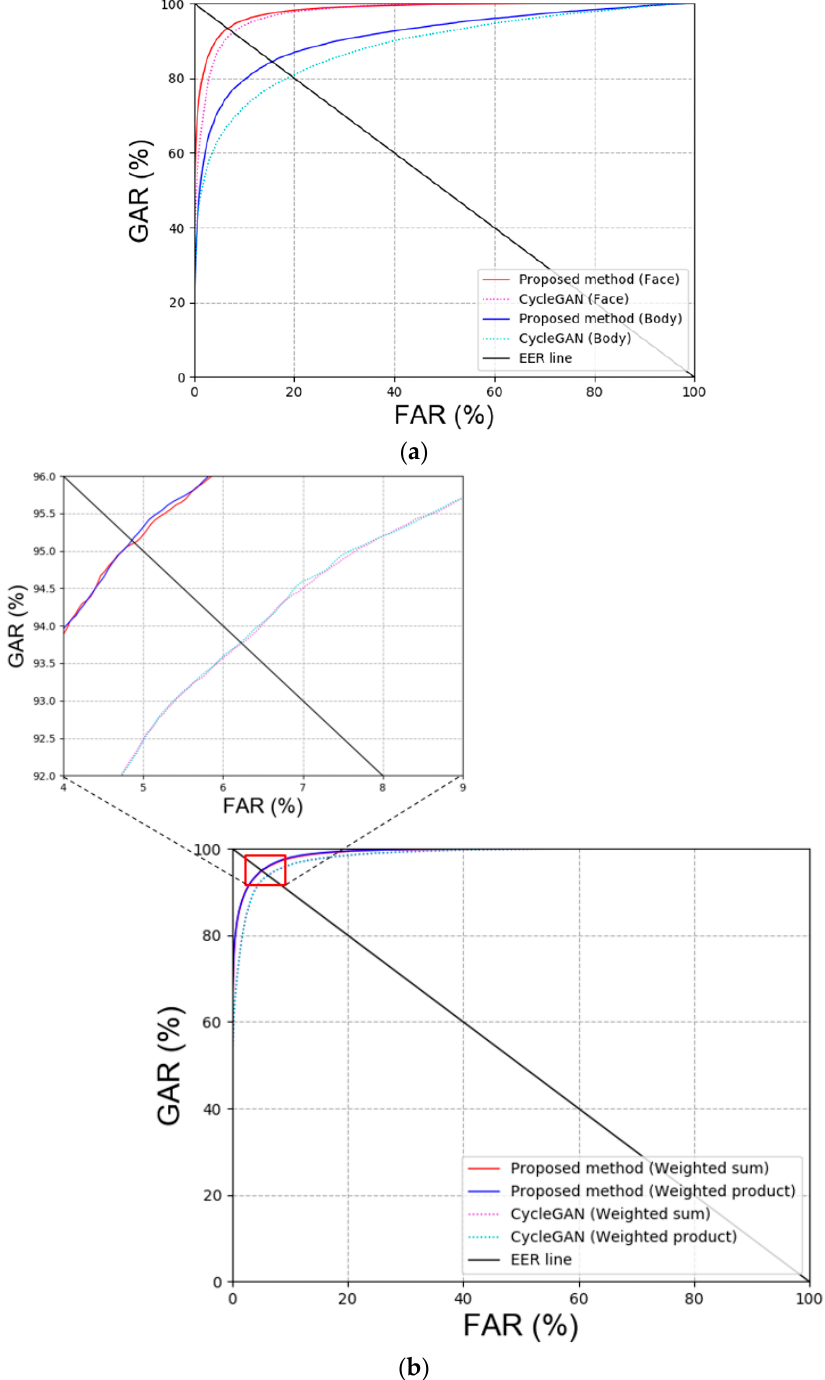
Figure 15. ROC curves for the proposed and CycleGAN in ChokePoint dataset. ( a ) Face and body recognition result and ( b ) score-level fusion result.